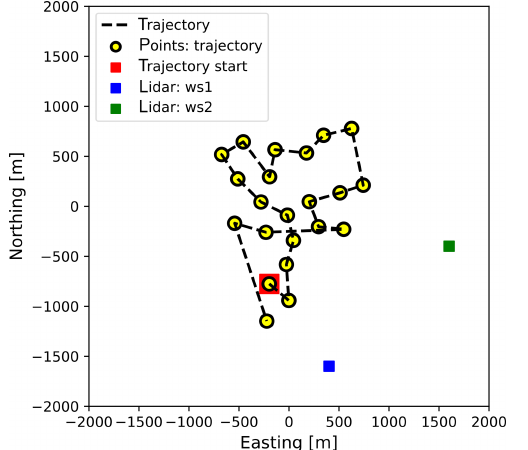
Figure 7. Final campaign design at Scottish site.